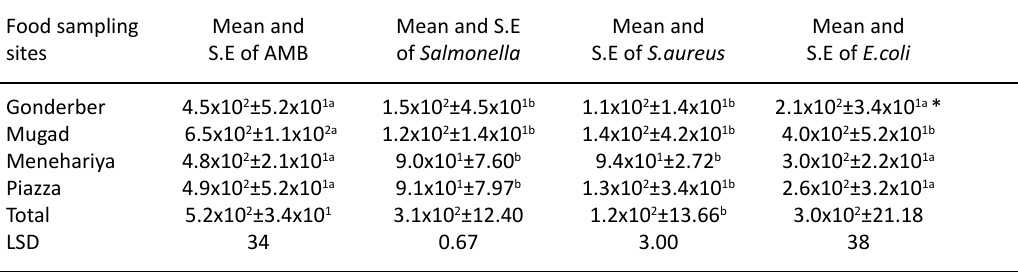
Table 4. Mean and standard error of bacteriological counts of AMB, Salmonella, S.aureus and E.coli CFUg -1 in Woldia town Food sampling